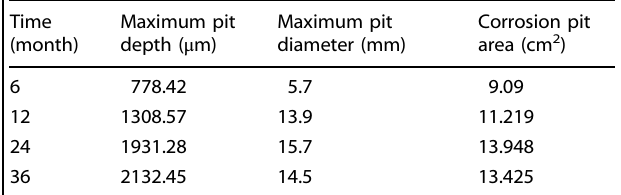
Table 2. Statistical results of barnacle-induced crevice corrosion on 316L SS immersed for different